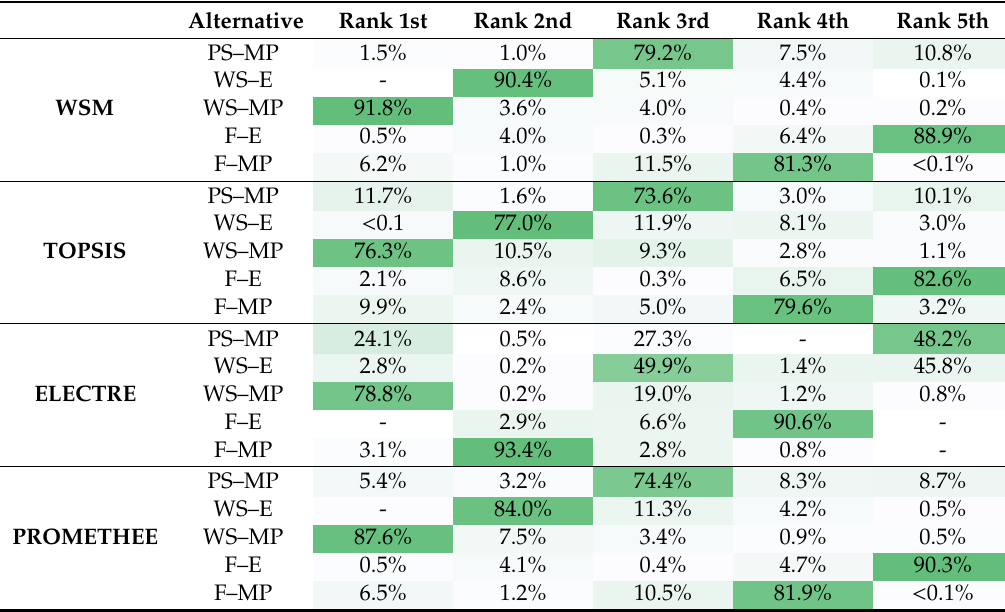
Table 6. Rank probabilities with stochastic weights.